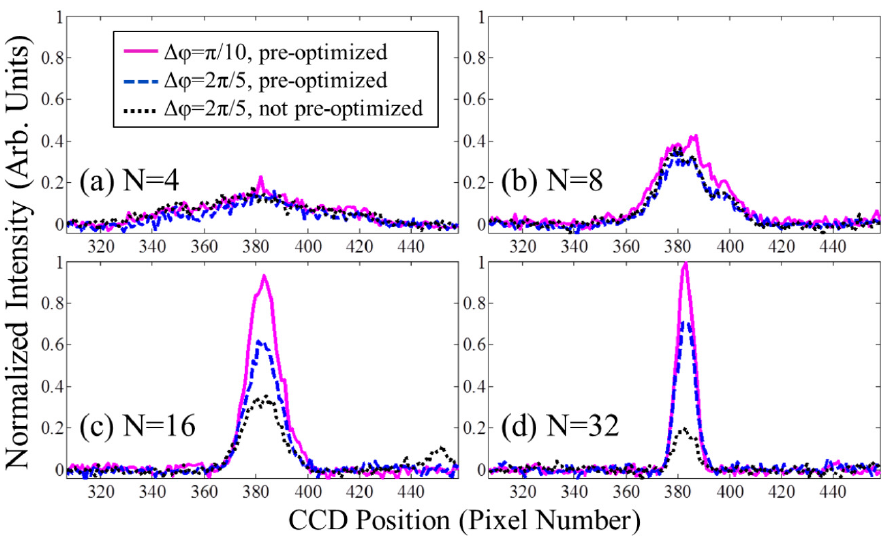
Figure 4. Intensity cross-sections from the CCD using the graphite reflector performed both with and without pre-optimization. The SLM is divided into ( a ) 4 × 4 segments, ( b ) 8 × 8 segments, ( c ) 16 × 16 segments and ( d ) 32 × 32